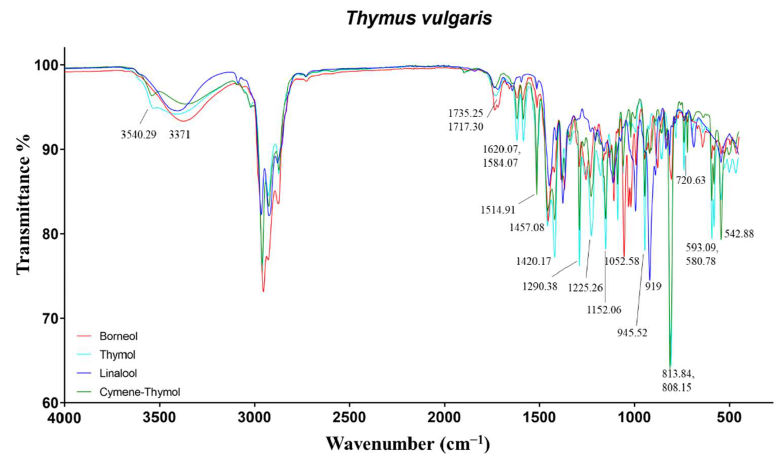
Figure 5. ATR-FTIR spectra of borneol, Thymol, Linalool, and Cymene-Thymol chemotypes of Thymus vulgaris.